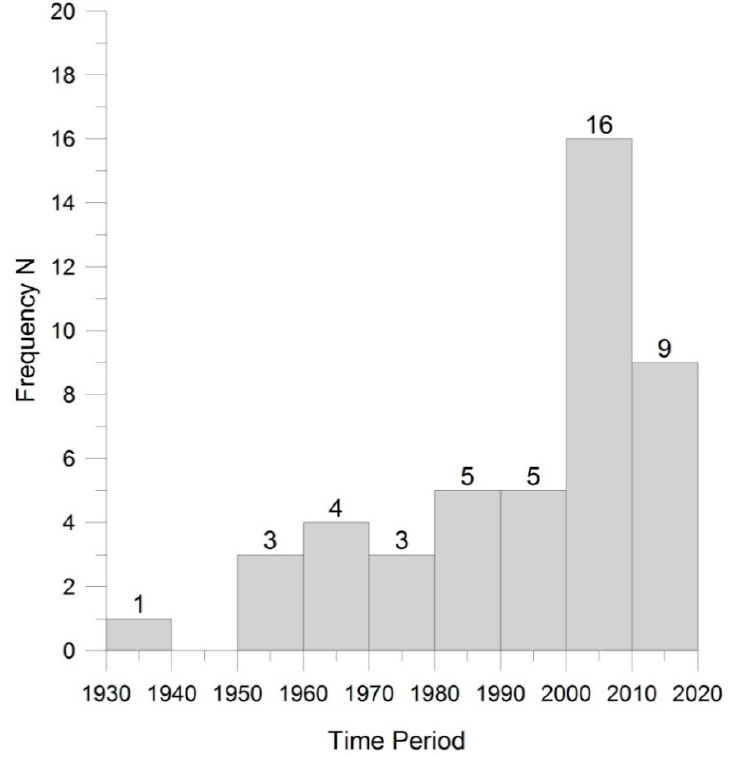
Figure 3. Frequency of rockfalls for the period between 1935 and